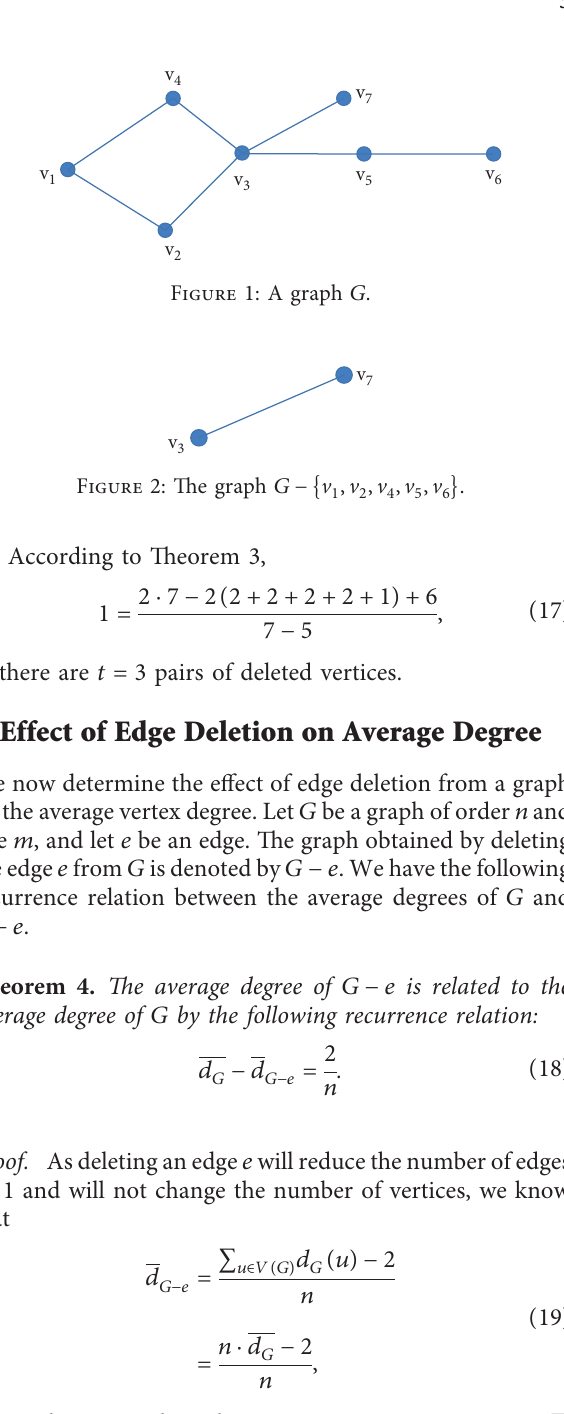
Figure 1: A graph G .